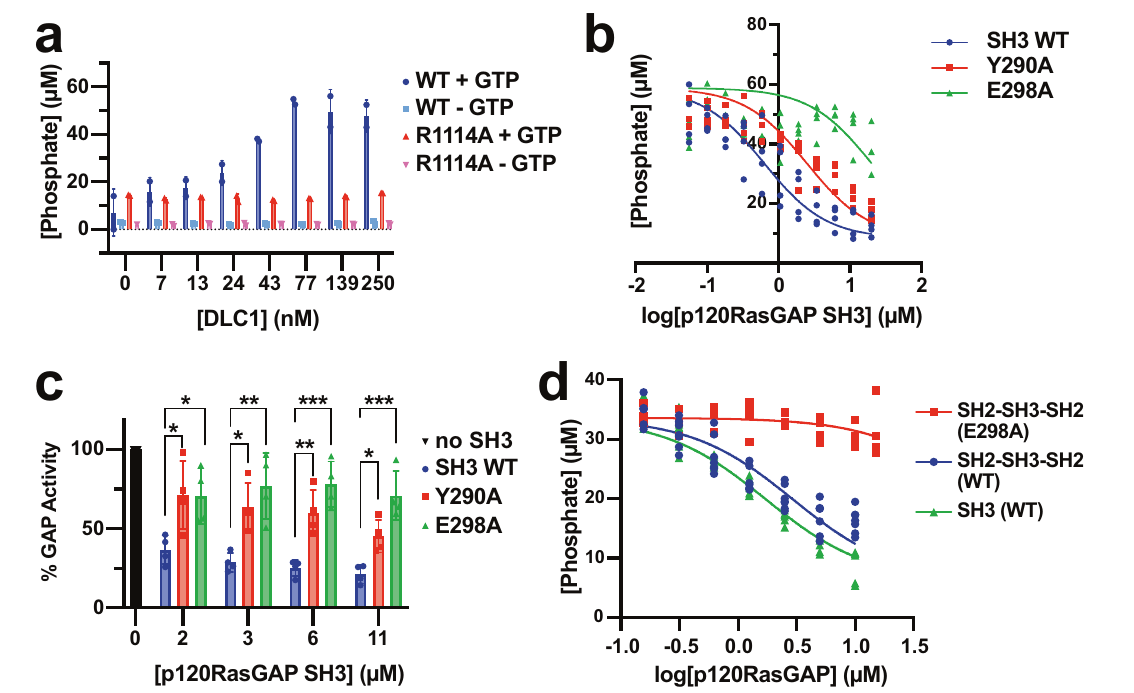
Fig.4 |Biochemicalassessmentofp120RasGAPSH3domaininhibitionofDLC1 RhoGAP activity. a DLC1 RhoGAP wild-type (WT, blue and cyan) but not R1114A mutant (red and pink) stimulates RhoA GTPase activity. The concentration of phosphate generated ( μ M) with added GTP (+GTP) or without GTP ( − GTP) is shown. Data are shown as mean values (bars) +/ − SD (error bars), and individual measurements are plotted (dots, n =2). b Titration of p120RasGAP SH3 domain (0 – 20 μ M) wild type (WT, blue) and structurally de fi ned mutants Y290A (red) and E298A(green)toinhibitDLC1RhoGAPactivity.Thephosphategenerated(in μ M)is plottedagainstthelog10ofSH3concentration( μ M),IC 50 valueswerecalculatedby nonlinearregression(lines), andindividualmeasurements areplotted (dots, n =4). c Representative SH3 domain concentrations from ( b ) (2, 3, 6, and 10 μ M). % GAP activity is normalized to the maximum phosphate generated by DLC1 stimulated RhoA (black bar, 100%). Data are mean values (bar graph) +/ − SD (error bars), and